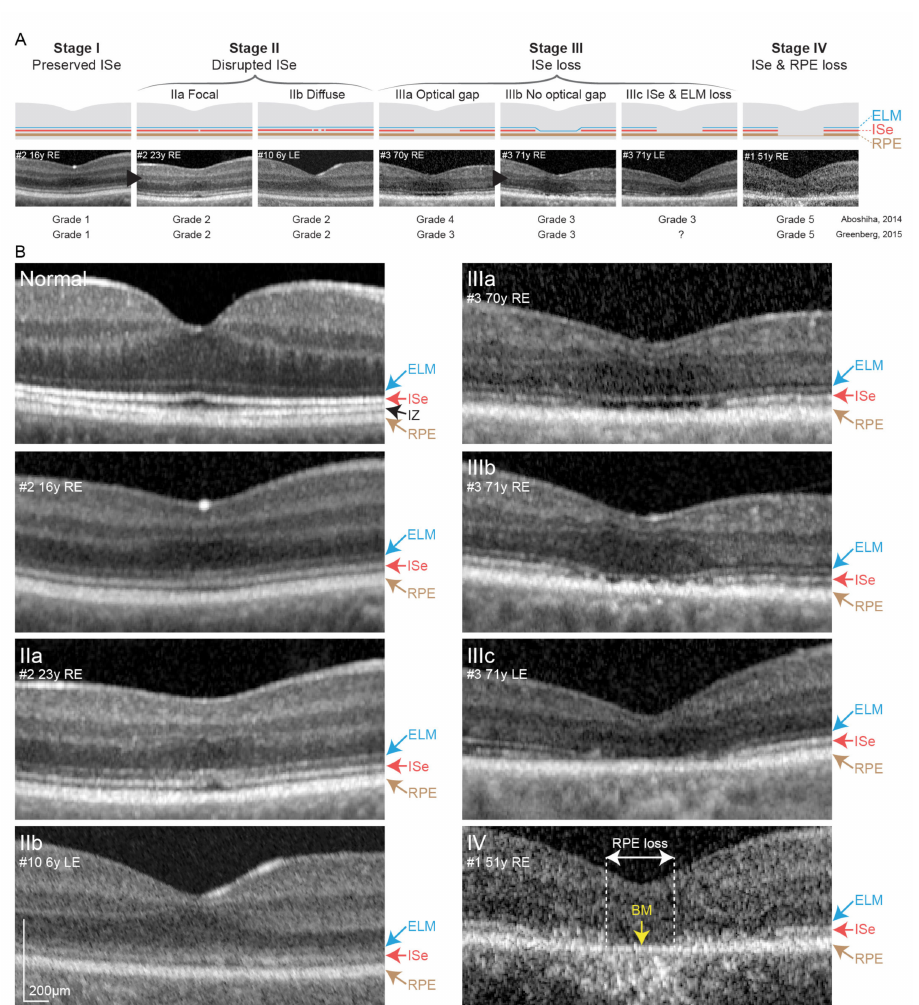
Figure 4. Proposed OCT staging. ( A ) Proposed OCT staging that was created based on observations from Figure 1. Representative OCT figure is shown for each stage. Cases, where progression was observed, are marked with a black arrowhead. Grading based on the previous proposal by Aboshiha et al. [22] and Greenberg et al. [19] is shown below. Note the differences in grades 3 and 4. ( B ) Enlarged OCT images from ( A ). A normal OCT image is placed on the top left, showing the normal foveal structure and the presence of the interdigital zone between the ISe and RPE. Stages IIIa-c are characterized by ISe loss but differ in the presence/absence or shape of ELM. Stage IV is characterized by RPE loss (marked with white arrows). Bruch’s membrane remains as a thin hyperreflective line in that area (marked with yellow arrow), while increased reflectivity of the choroid may be seen. Abbreviation explanation: RE—right eye, LE—left